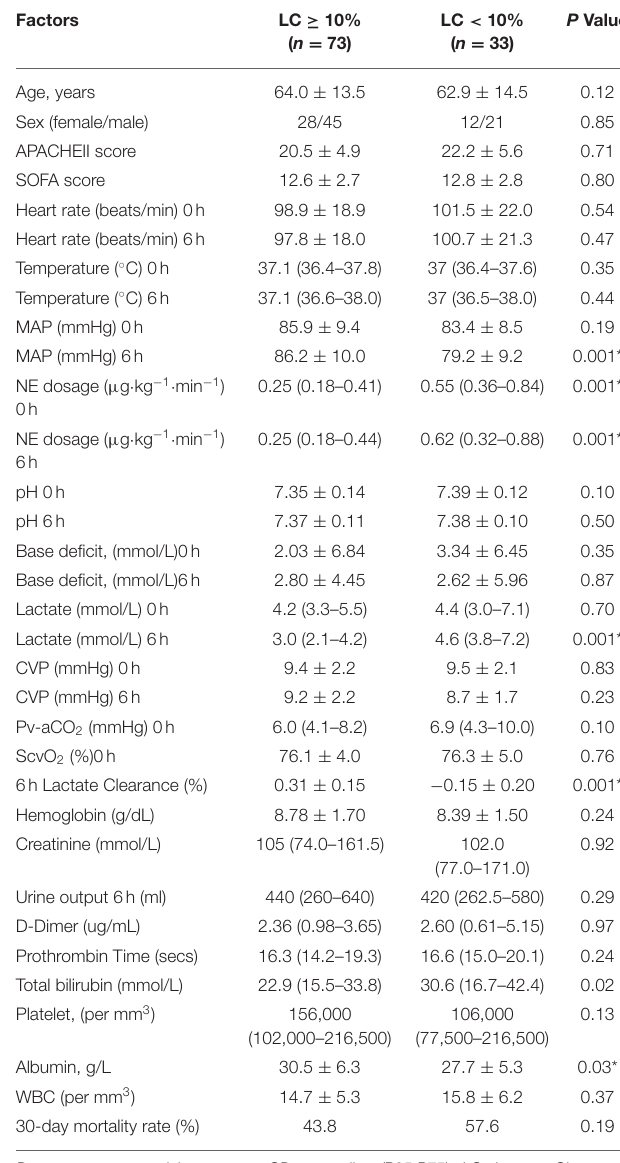
TABLE 1 | Baseline characteristics and clinical data of the septic shock patients in ICU.